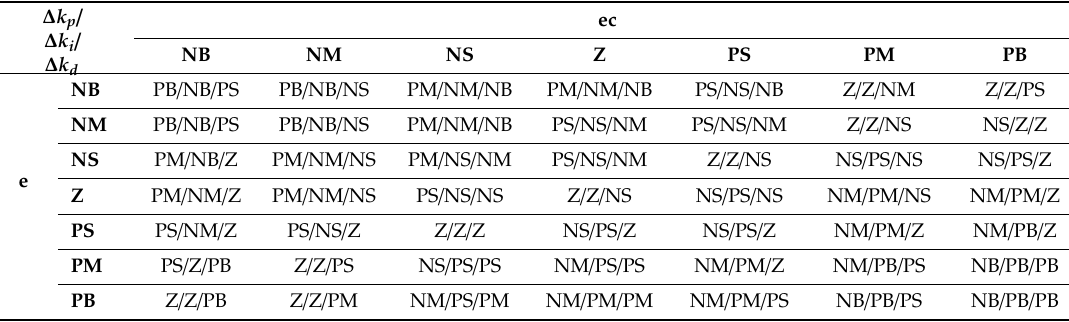
Table 1. Table of FPID mode and